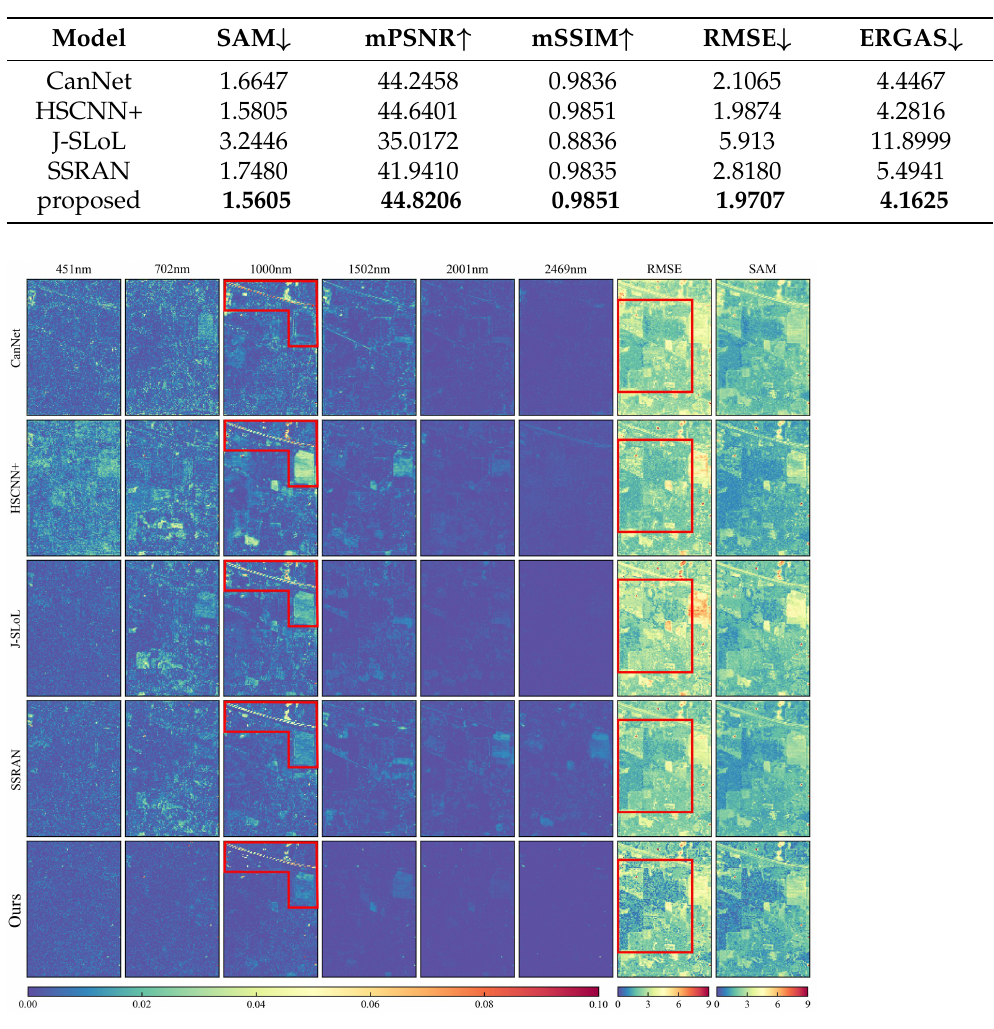
Figure 6. Visualization of SSR results of five methods using Indian Pines dataset. Columns 1 to 6 show the absolute error of a single band. Columns 7 and 8 show the overall RMSE and SAM errors for all bands, the highlighted areas in the red rectangle are roads and hay in the 1000 nm. Additionally, the proposed method has a darker blue color in the red box in the RMSE heat maps, indicating superior